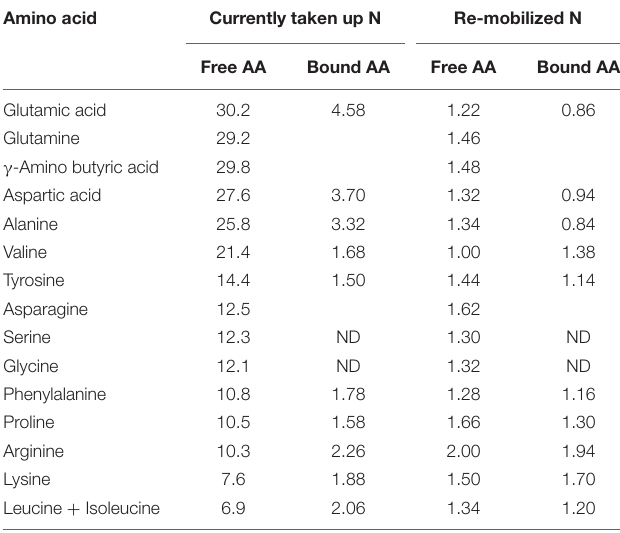
TABLE 1 | Percentages of N in free and bound amino acids (AA) in youngest 6 th leaf either derived from the ammonium taken up for 24 h at the 4 th leaf growth at day 22 (Re-mobilized N) or from ammonium taken up for 10 h just before harvest (Currently taken up N] at day 31.